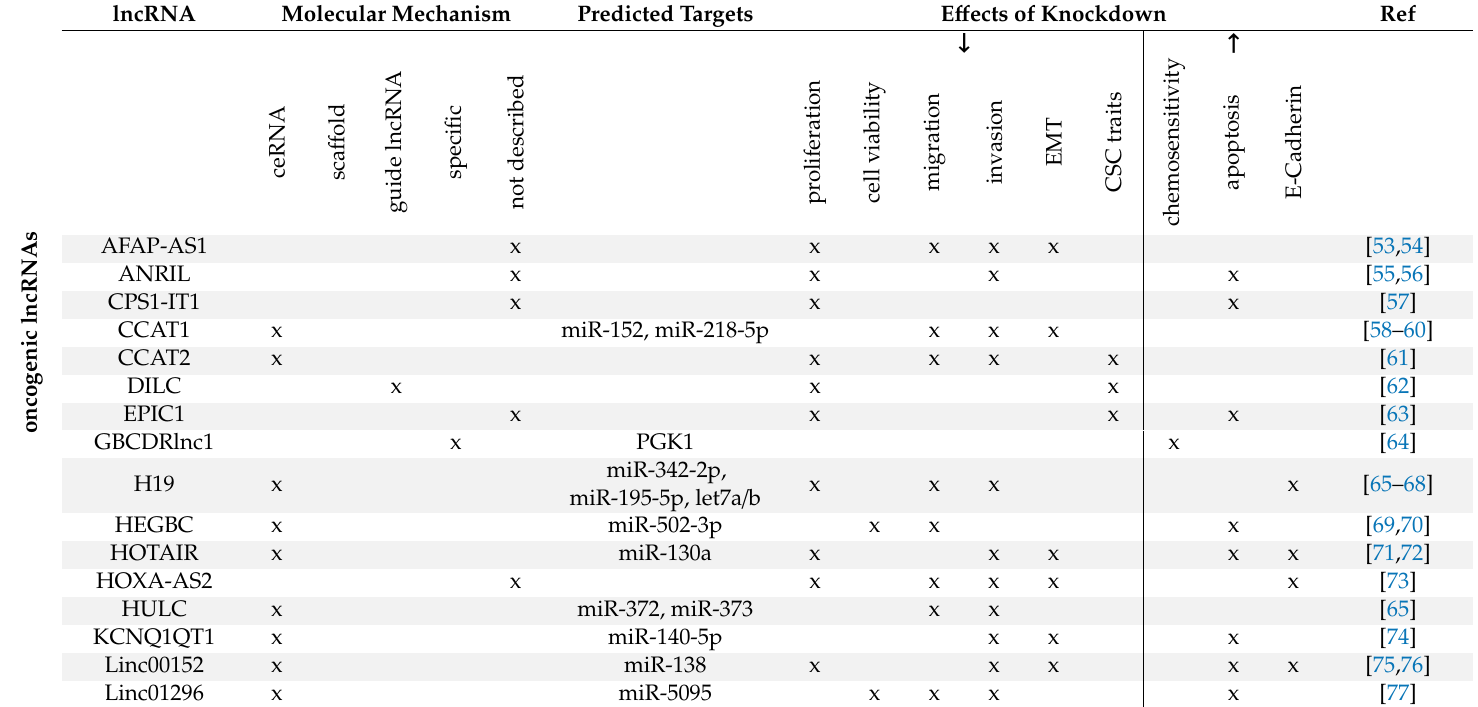
Table 2. Overview of the molecular mechanism predicted targets and e ff ects of knockdown of oncogenic and suppressive lncRNAs based on in vitro studies in biliary tract